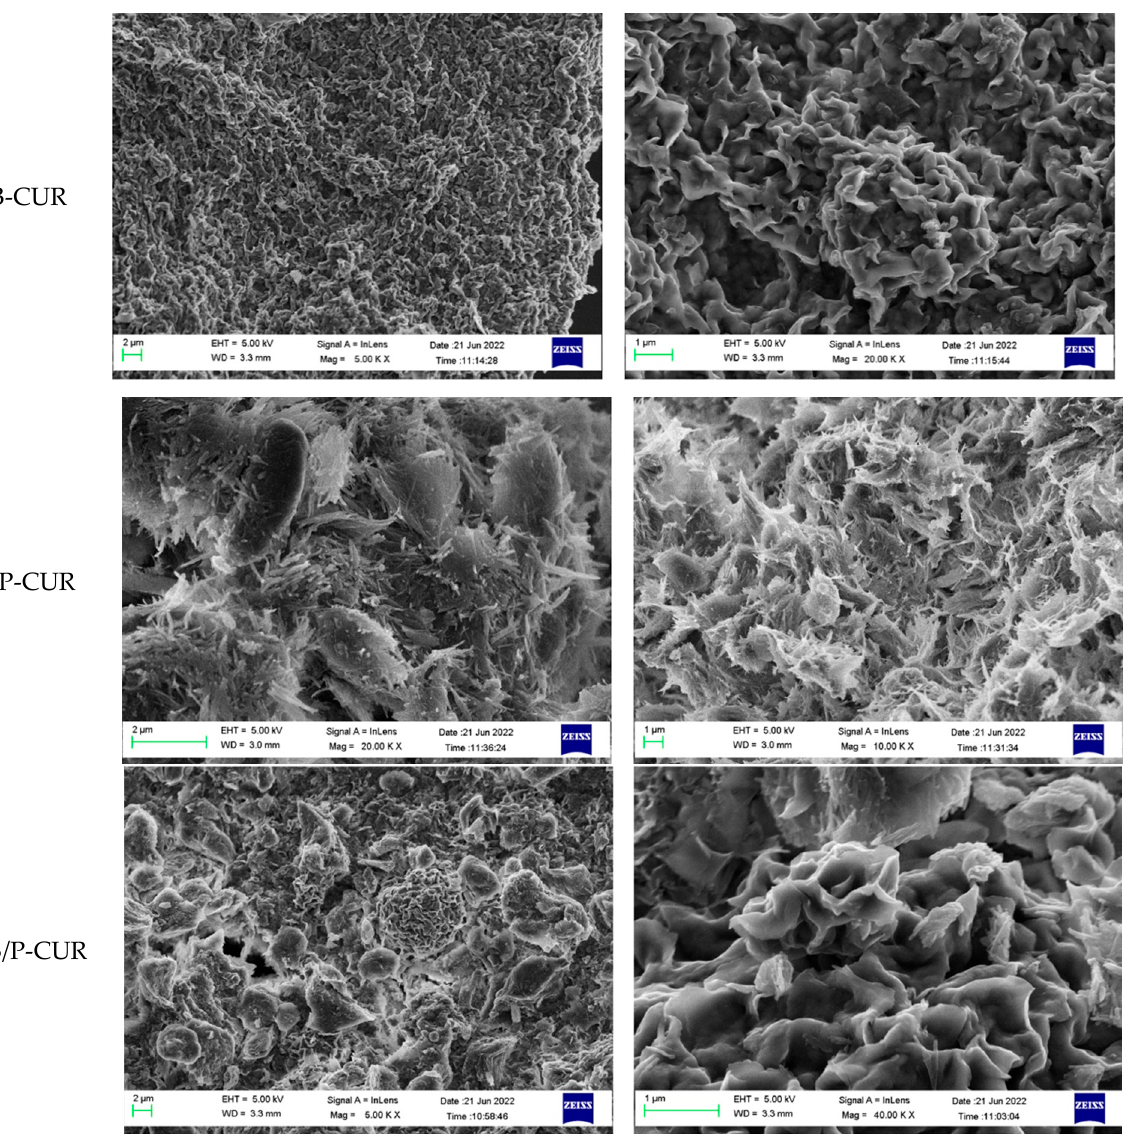
Figure 3. SEM microphotographs of freeze-dried B-CUR (top panel), P-CUR (middle panel), and B/P-CUR (bottom panel) hydrogels.